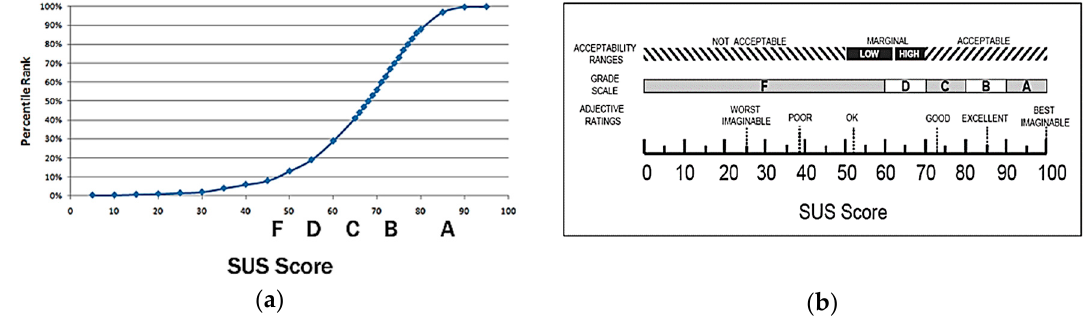
Figure 5. ( a ) Percentile rankings of SUS scores; ( b ) grade rankings of SUS scores.